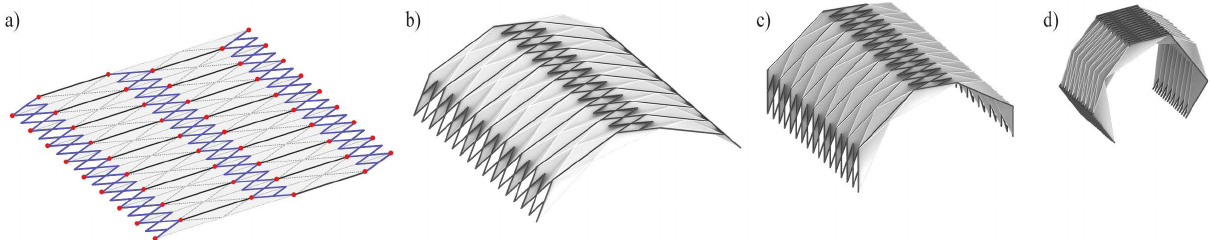
Figure 10: Yoshimura CP deployable vault: a) expanded, b) and c) intermediate, d) retracted